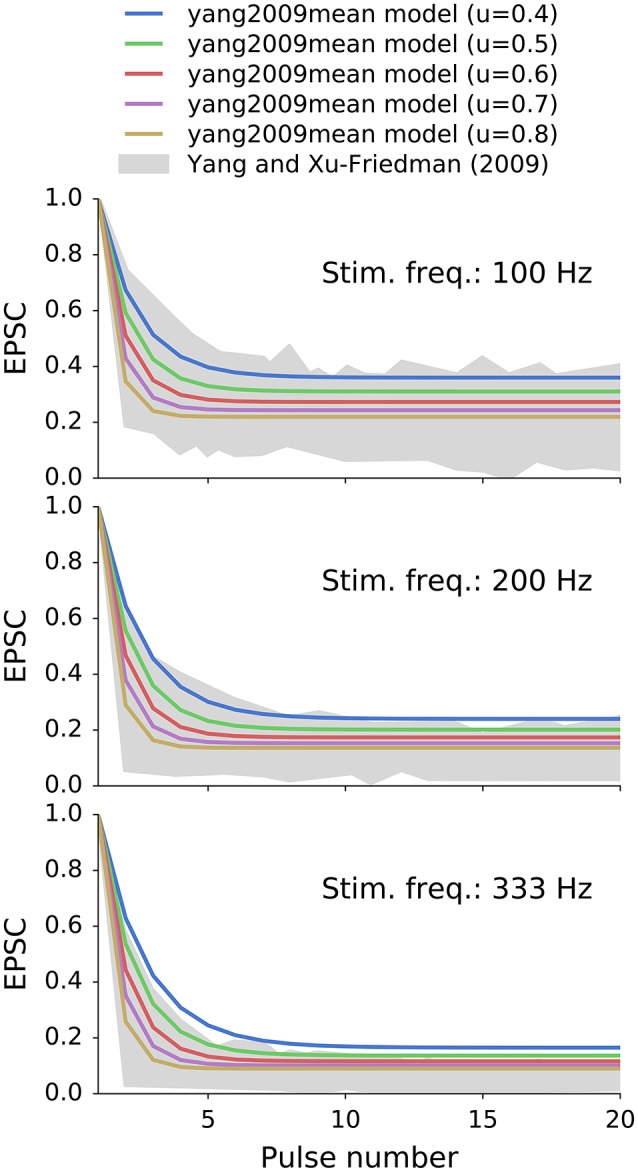
Synaptic depression of a double exponential recovery synapses (yang2009mean) with different values of u that were stimulated at 100, 200, 333 Hz. Synapse's recovery times constants were equal to the mean population values from in vitro experiments of Yang and Xu-Friedman (2009). The selected value of u was 0.6 as measured by Oleskevich et al. (2000) in vitro. The grayed area represents the population data from Yang and Xu-Friedman (2009).